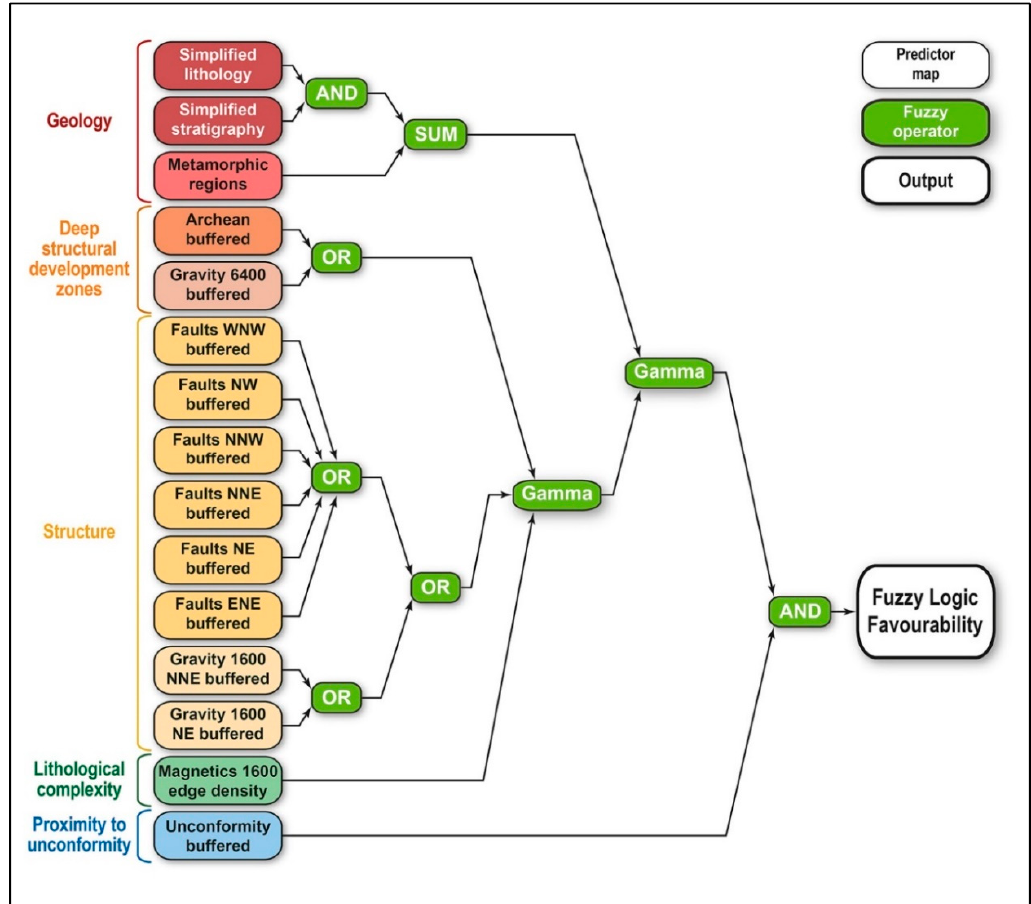
Figure 10. NW McArthur Basin inference network. Predictor maps are grouped and shaded according to their recognition criteria class. Fuzzy logic operators are used to combine weighted and rasterised predictors via a series of intermediate steps to produce the final fuzzy logic favourability map.